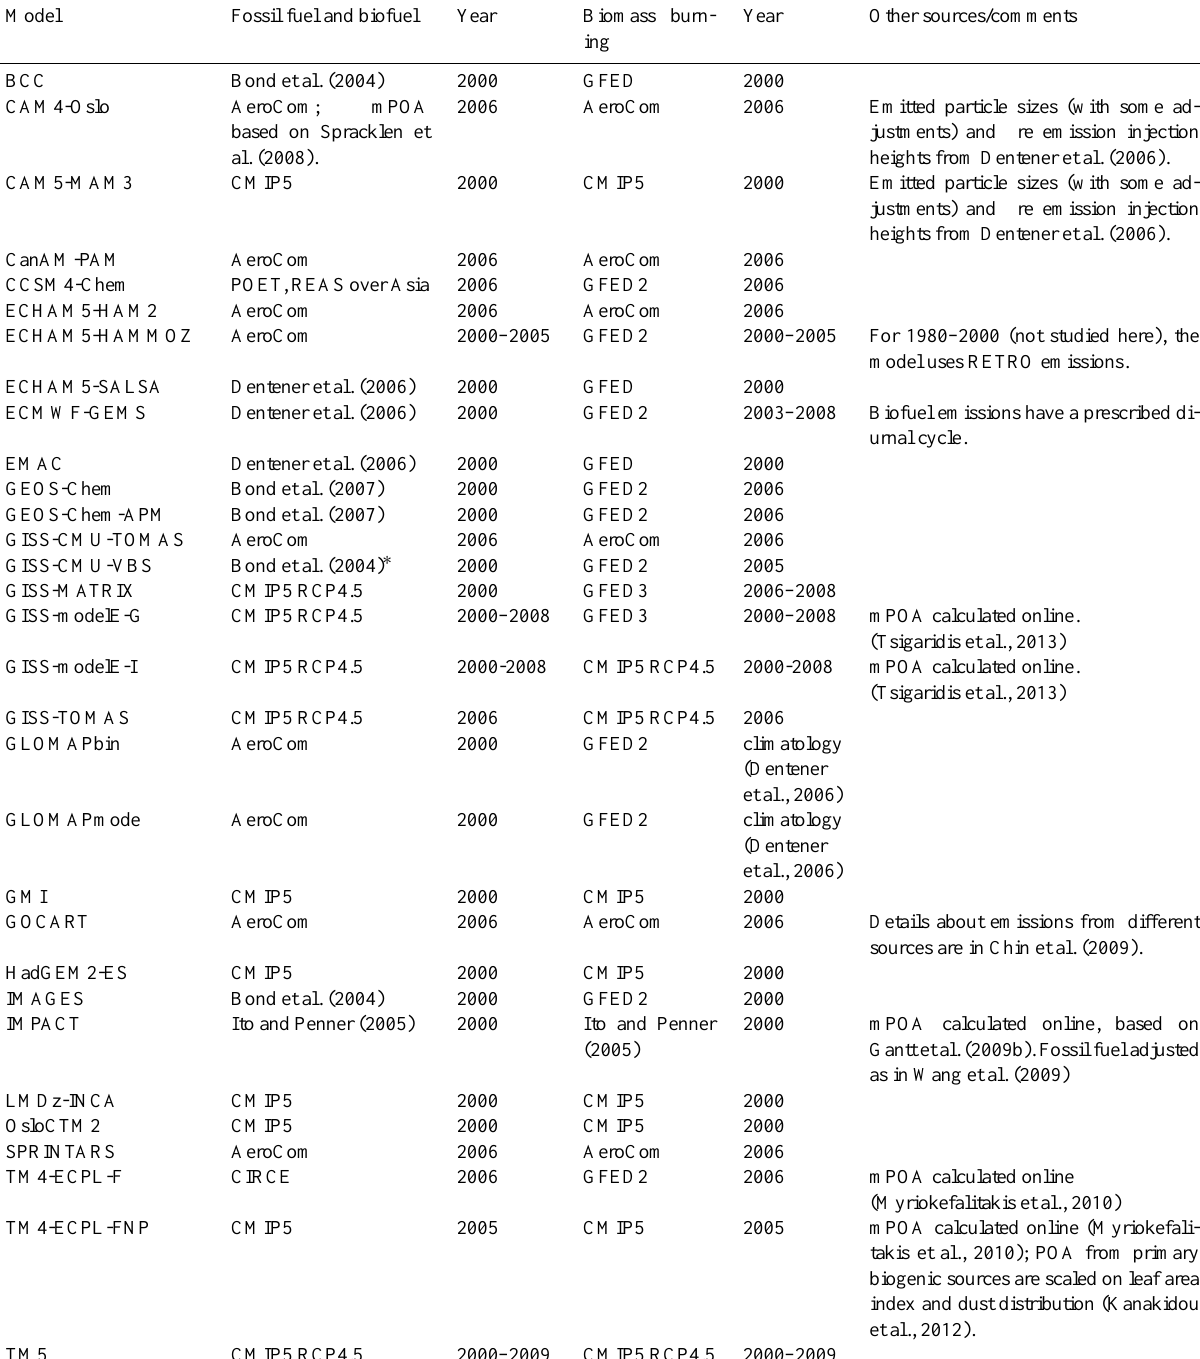
Table 4. Primary organic aerosol emissions adopted by the